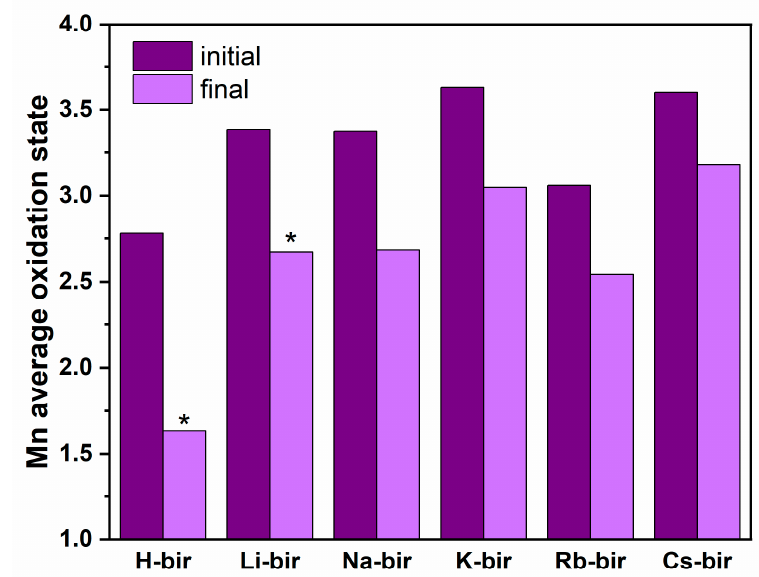
Figure 11. Manganese average oxidation state before and after oxygen release tests. * For H-bir and Li-bir, the stoichiometric formula AMn 4 O 8 was used; for other samples, values from the XRF analysis were used.